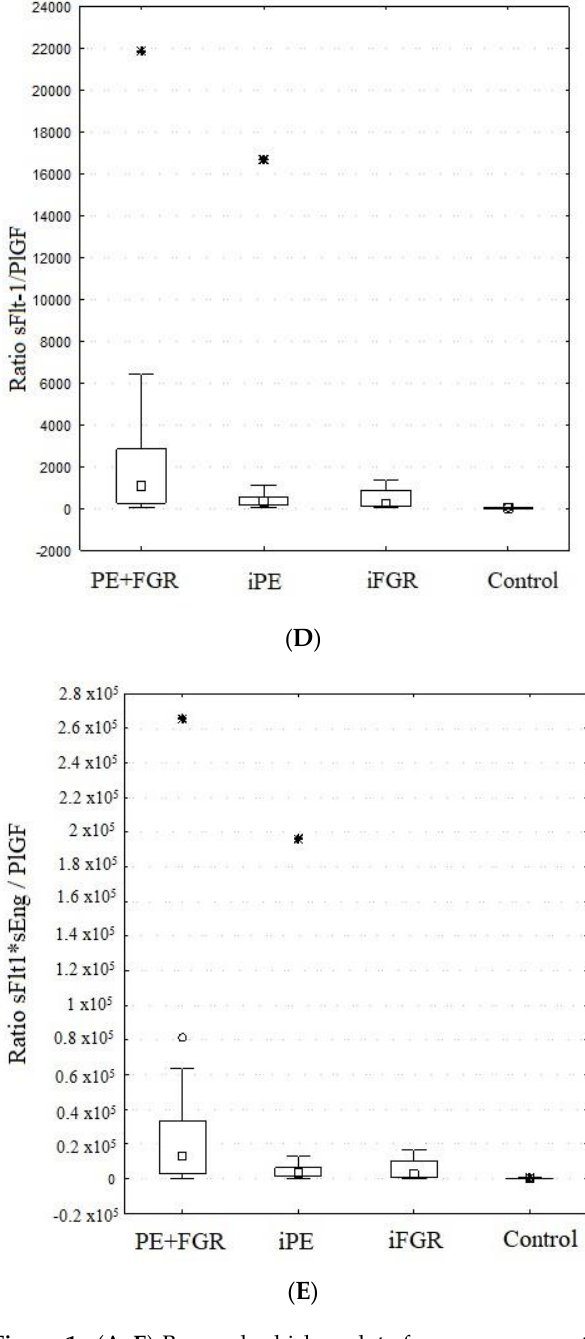
Table 6. Distribution of the sFlt-1/PlGF ratio in each study subgroup in the low, intermediate, high or very high risk groups according to the currently recomended cutoff values.